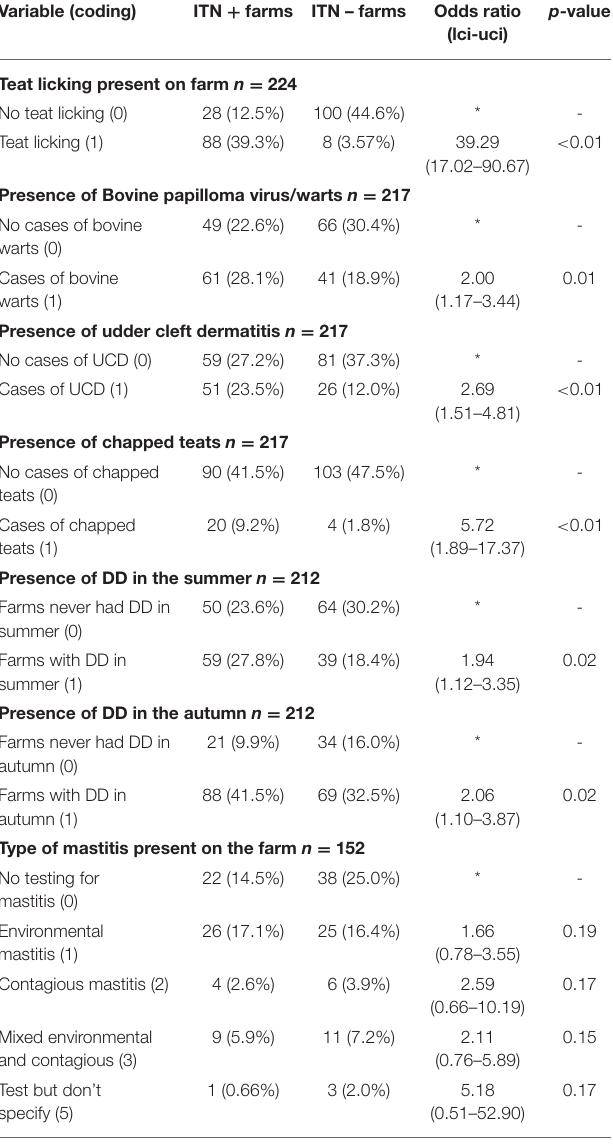
TABLE 2A | Univariable “disease” associations with ischaemic teat necrosis (ITN) as the outcome variable. Variable (coding) ITN + farms ITN – farms